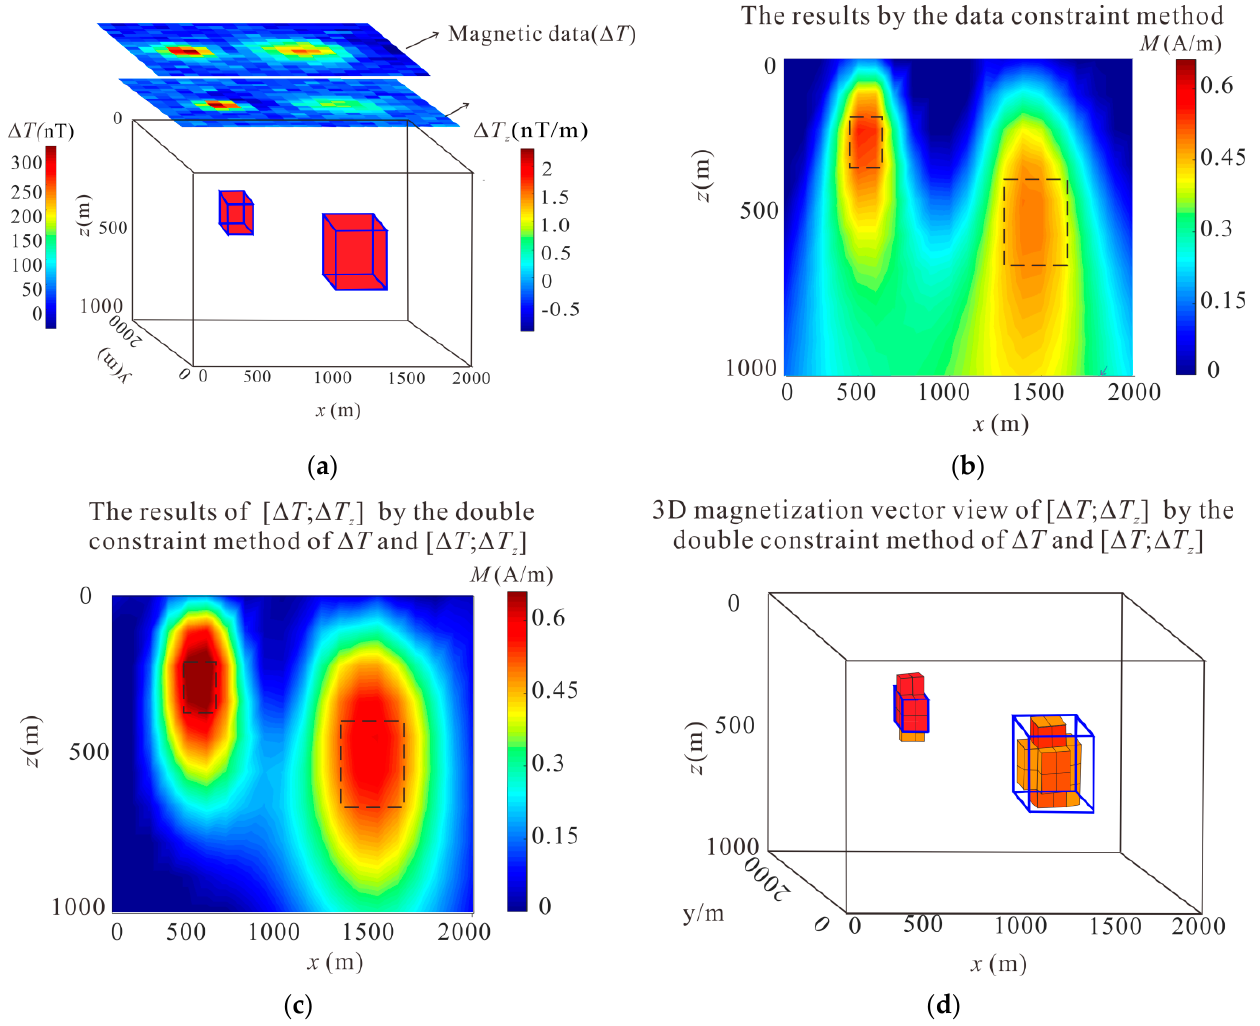
Figure 4. Models with Gaussian noise obtained by the data constraint and double constraints inver- sion method of CMG data and airborne magnetic data. ( a ) Airborne magnetic and gradient anomaly; ( b ) the results of CMG data by the data constraint inversion method, with slices corresponding to y = 1000 m; and ( c , d ) the results of CMG data with Equation (8) by the double constraints inversion method and corresponding 3D magnetization vector view with a cutoff value 0.471 A/m, with slices corresponding to y = 1000 m.